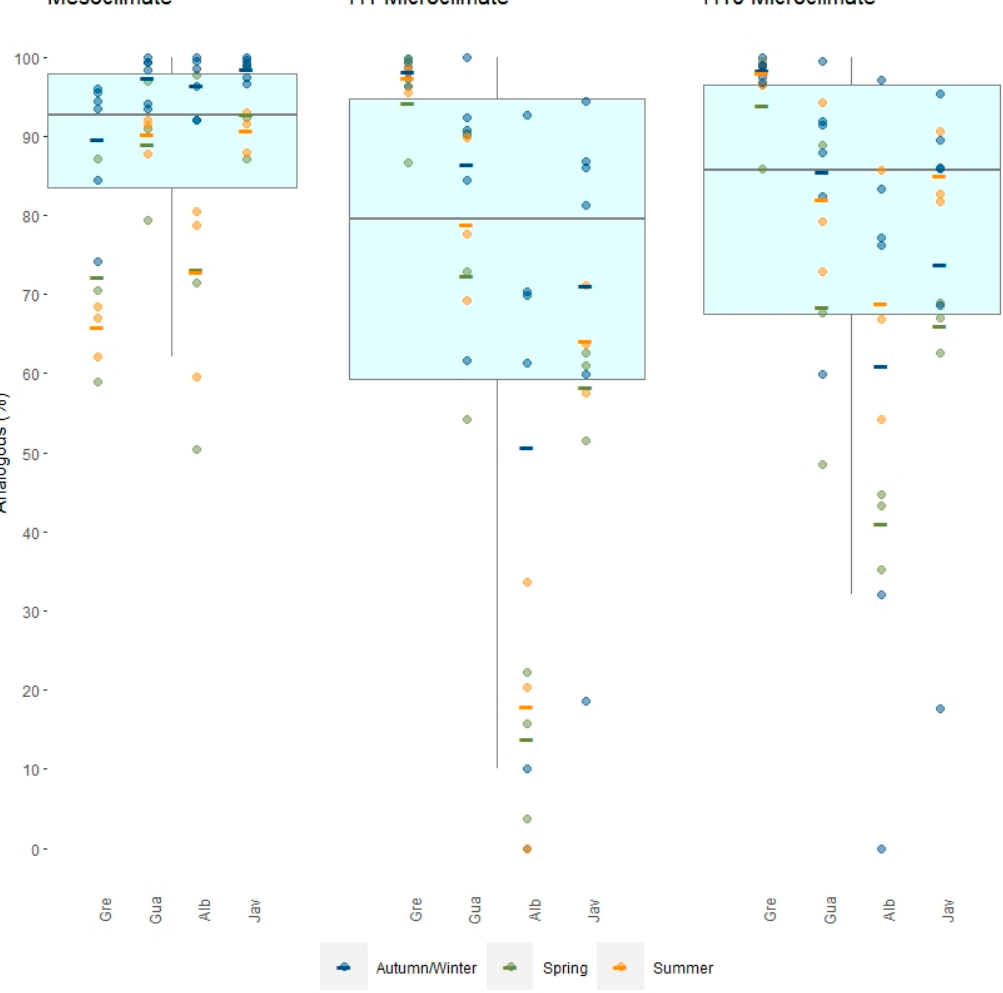
H10 (short grassland) (Table 1). The selected models included effects of scale, region, sea ‐ son (spring, summer and autumn/winter) and the interaction between scale and region. Overall, exposure was greatest in Albarracín (most negative coefficient), and least in Gre ‐ dos (reference category: all other regions had negative coefficients) where exposure at the microscale was minimal. Exposure to non ‐ analogous conditions was greater for the mi ‐ croclimate analysis (Figure 5), but with an interaction with region (positive coefficients with Guadarrama, Albarracín and Javalambre, because exposure at the mesoscale was greater in Gredos). The region:scale interaction was not present in the best model if Gre ‐ dos was removed from the analysis.